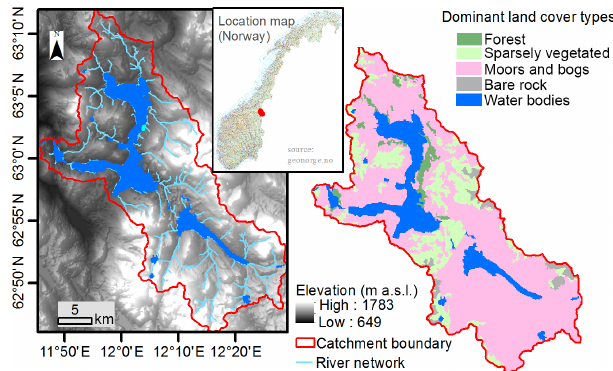
Figure 3. Physiography and location map of the study